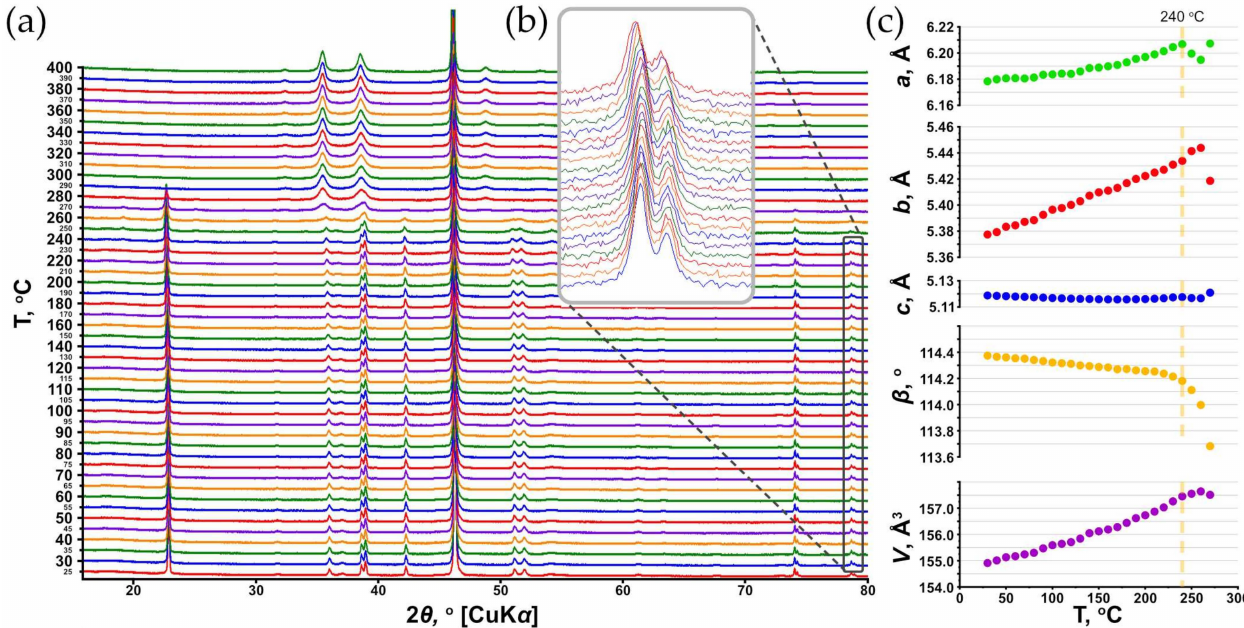
Figure 10. Powder X-ray diffraction patterns ( a ) and the unit cell parameters of SM as a function of temperature (30–400 ◦ C) under heating in air ( b ). The 11-4 reflection displacement in a temperature range of 30–230 ◦ C with a step of 10 ◦ C ( c ). ESDs of the unit cell parameters are within the limits of the